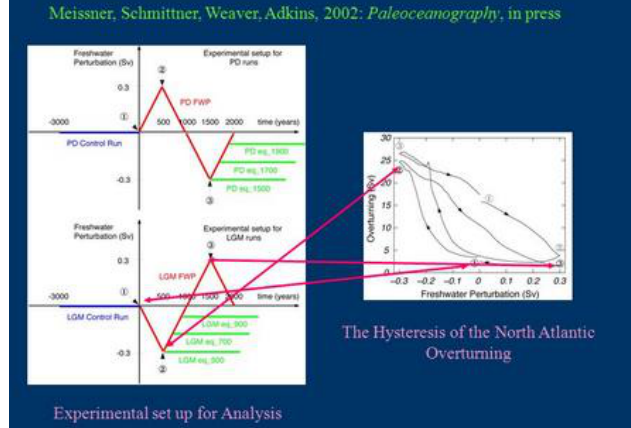
Figure 4. Analysis of Climate changes using weaver